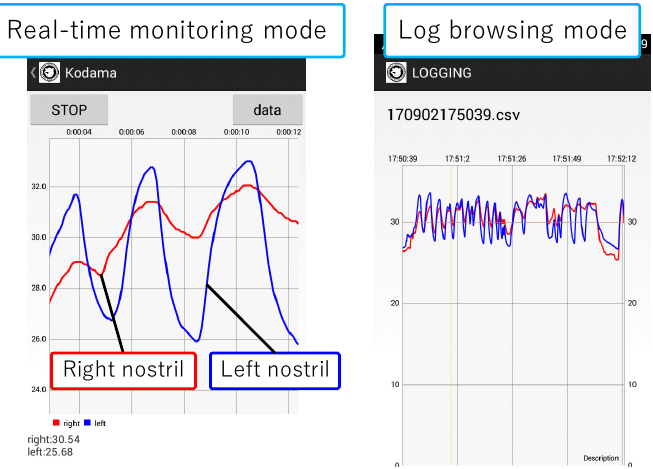
Figure 6. Screen of the Android